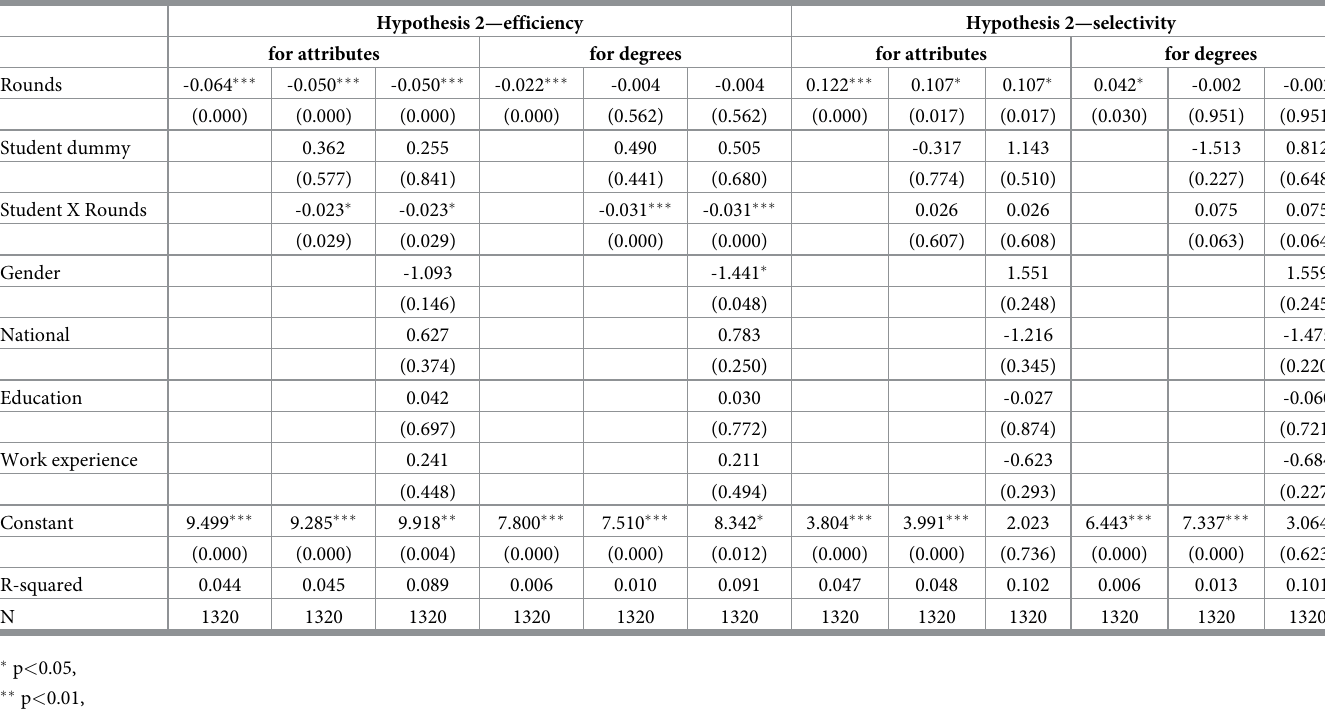
Table 3. Regression table H2. Random effects regression models for both attributes and degrees testing hypothesis 2 (p-values within